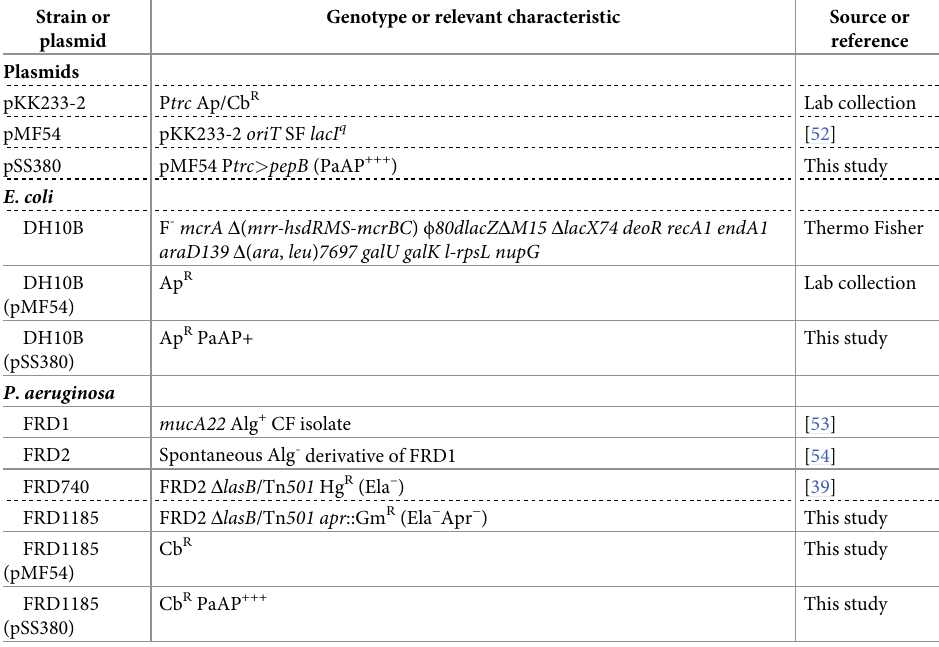
Table 4. Bacterial strains and plasmids used in this